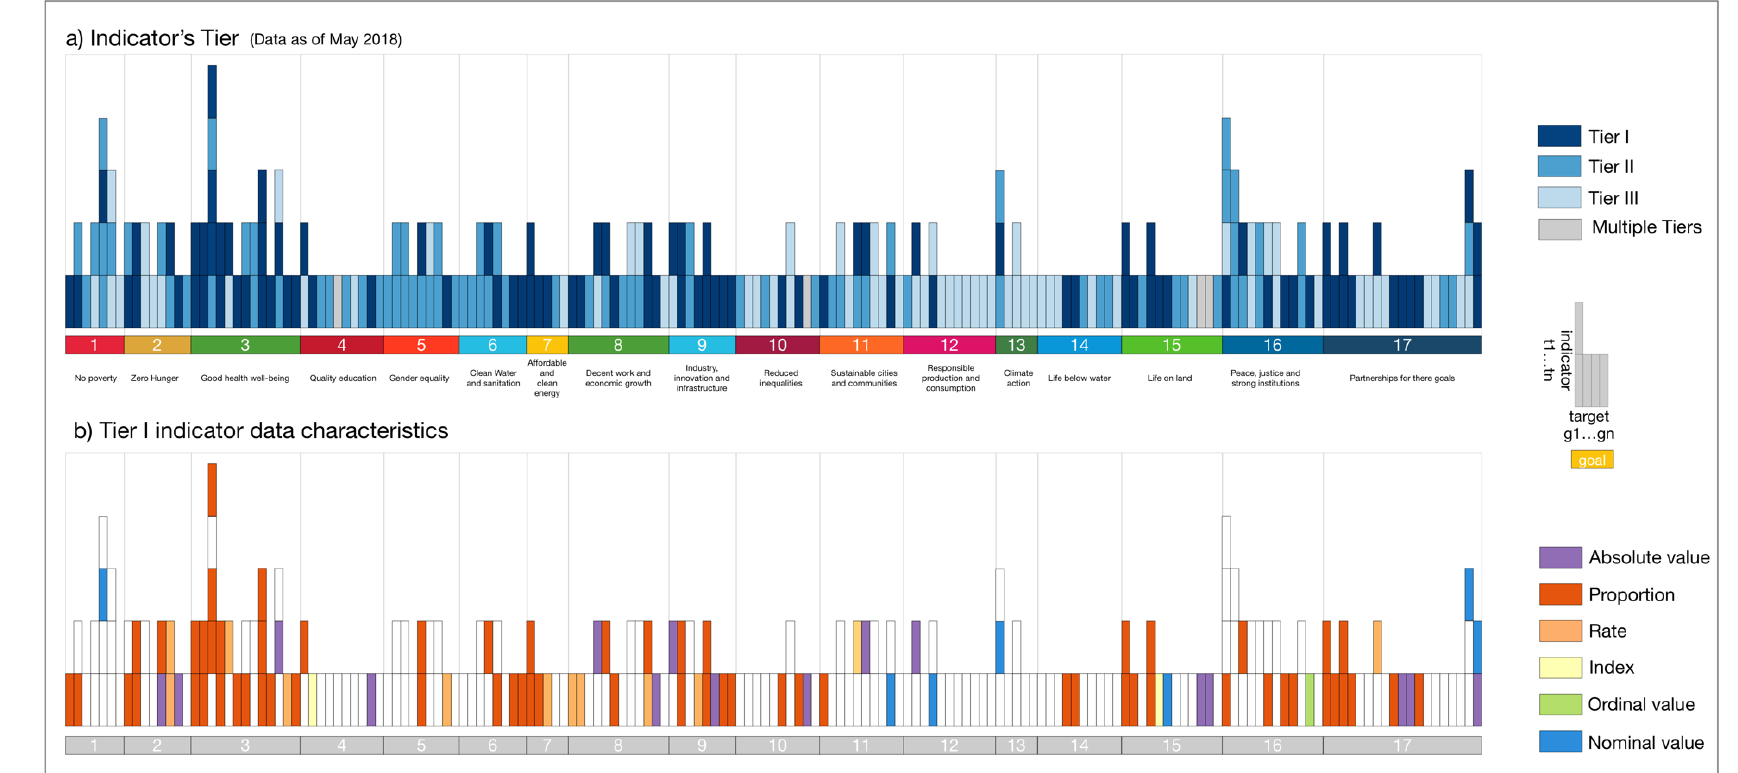
Figure 1. The Sustainable Development Goal (SDG) names and number of indicators for each including representation of tier level: ( a ) the indicator’s tier; ( b ) the tier I indicator’s data type.